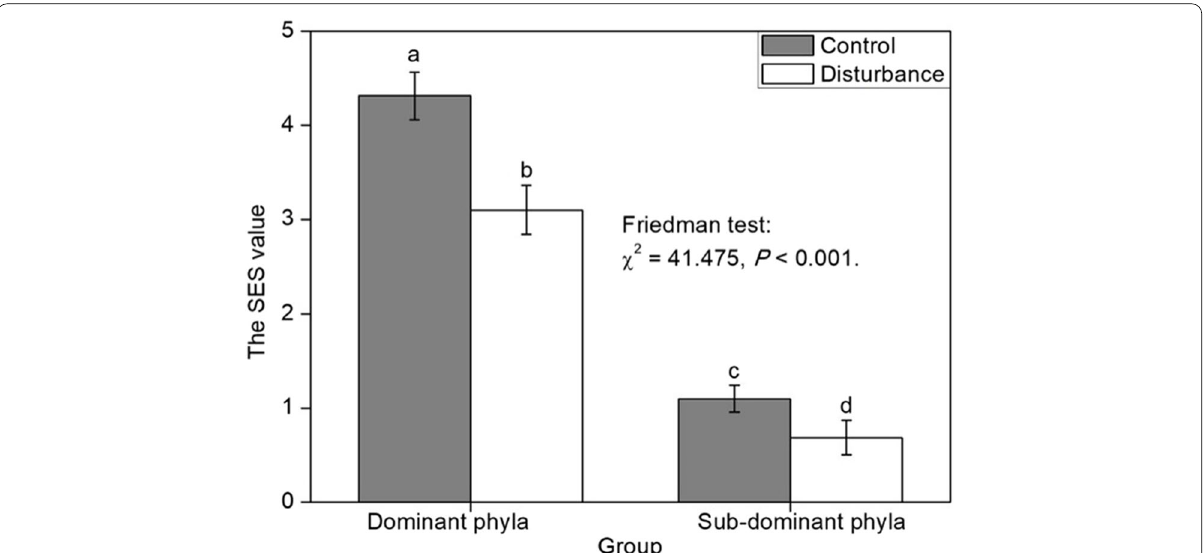
Fig. 2 The SES value for the four dominant and five subdominant bacterial phyla under the control and disturbance conditions. The value of SES (standard effect size) is calculated with a null model method, and it represents the magnitude of deterministic relative to stochastic processes in the process of community assembly. The mean and standard error of SES values under 16 conditions are shown. The different letters (from a to d) above the four groups meant that there were significant differences (Friedman test: P < 0.05) in the SES value between